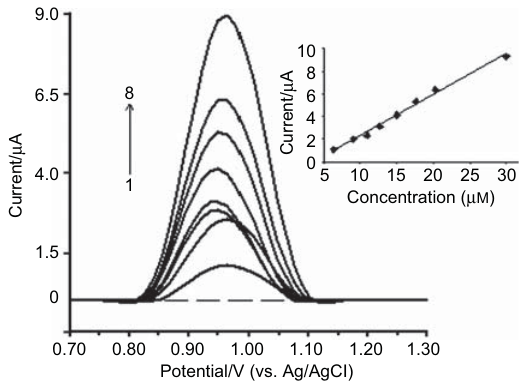
Figure 4 Successive additions of TU in phosphate buffer (pH 12.0) containing 20 m M NaCl. TU concentration: from 6.3 to 30 µ M (1 – 8). Dashed line represents background current. Inset: the corresponding calibration plot. For operating conditions, see the text.